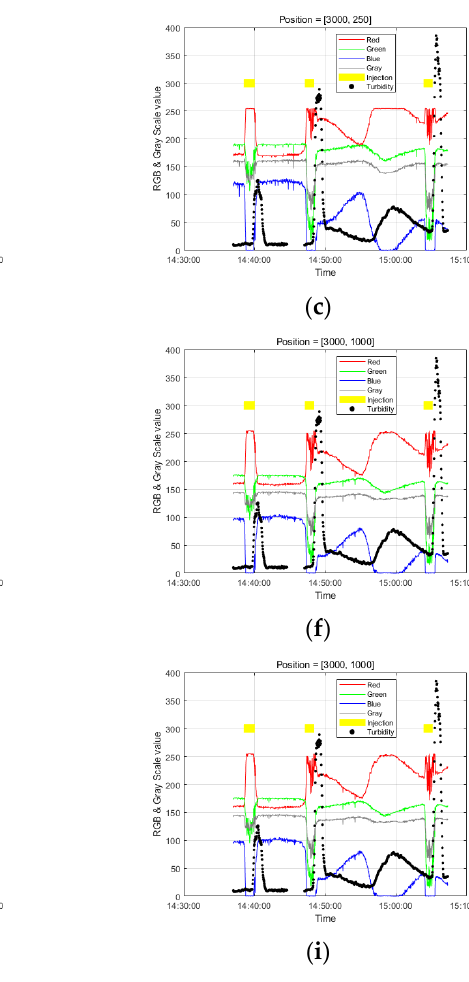
Figure 8. Changes in RGB and gray scale values due to the turbidity change at ( a ) [1000, 250], ( b ) [1970, 250], ( c ) [3000, 250], ( d ) [1000, 1000], ( e ) [1970, 1000], ( f ) [3000, 1000], ( g ) [1000, 1700], ( h ) [1970, 1700], and ( i ) [3000, 1700].